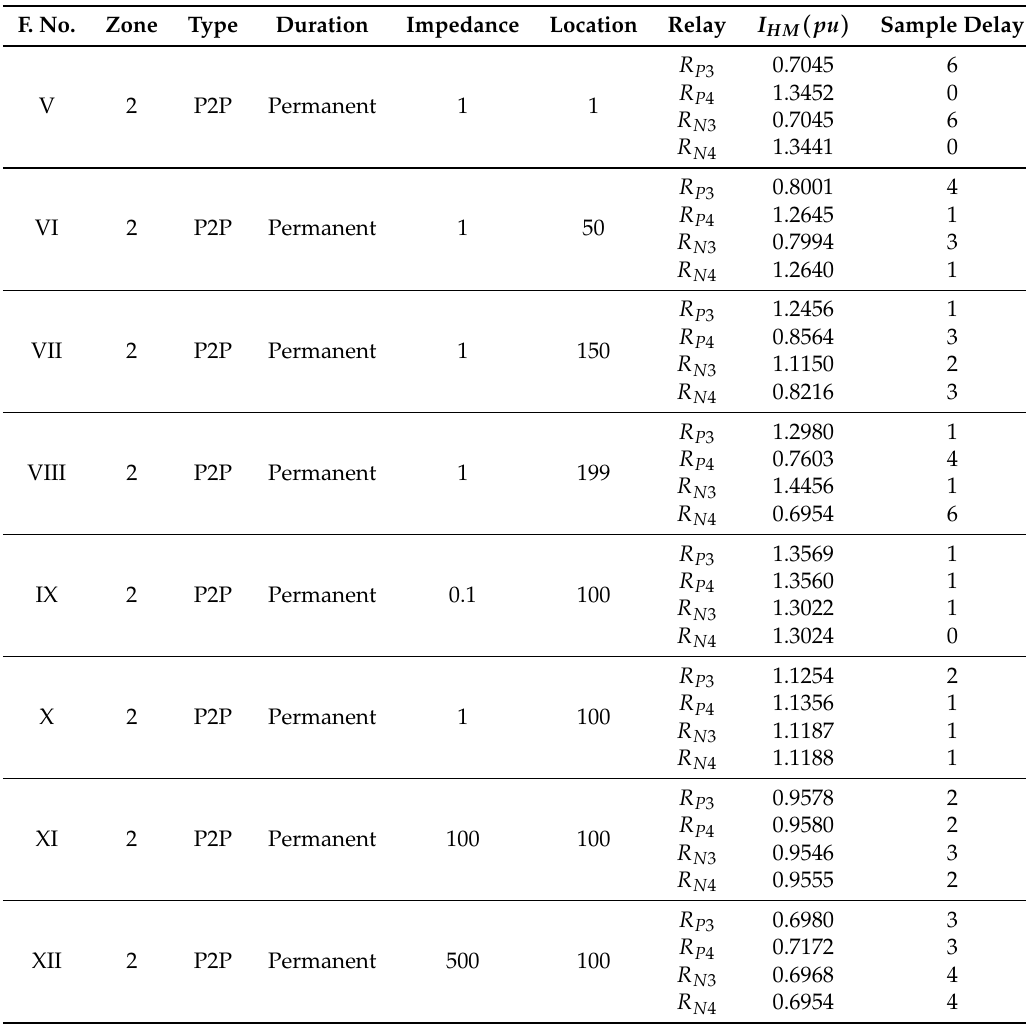
Table 6. Sensitivity analysis for internal fault scenarios of zone